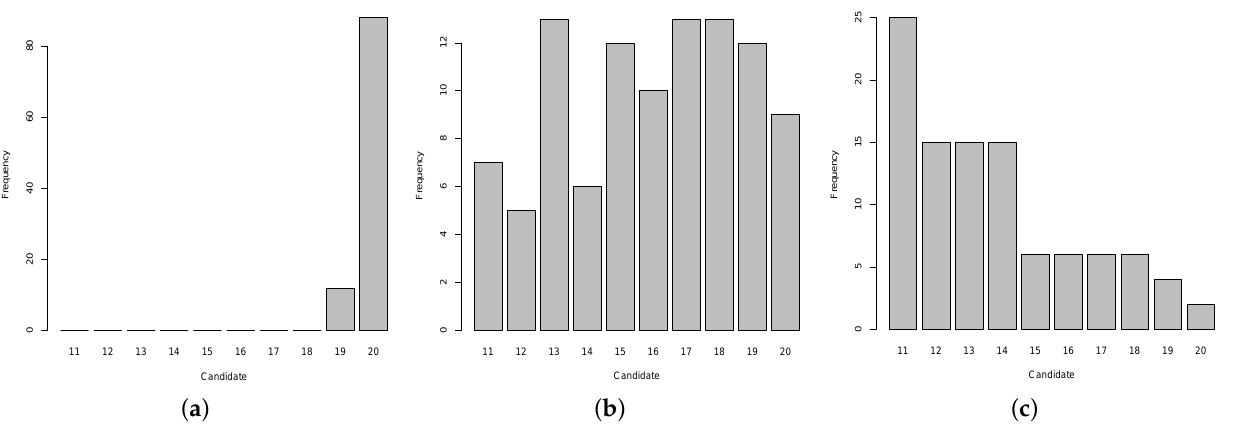
Figure 11. Bayesian optimality criteria are used to guide the sequential optimality process. The frequency tables plot the probabilities assigned to the first ten candidate points following the initial base design for a normal growth model. Panel ( a ) represents candidate probabilities under the ¯ U I criterion. Panel ( b ) plots probabilities of the candidates for ¯ U A criterion. Panel ( c ) provides the frequencies associated with ¯ U D criterion.